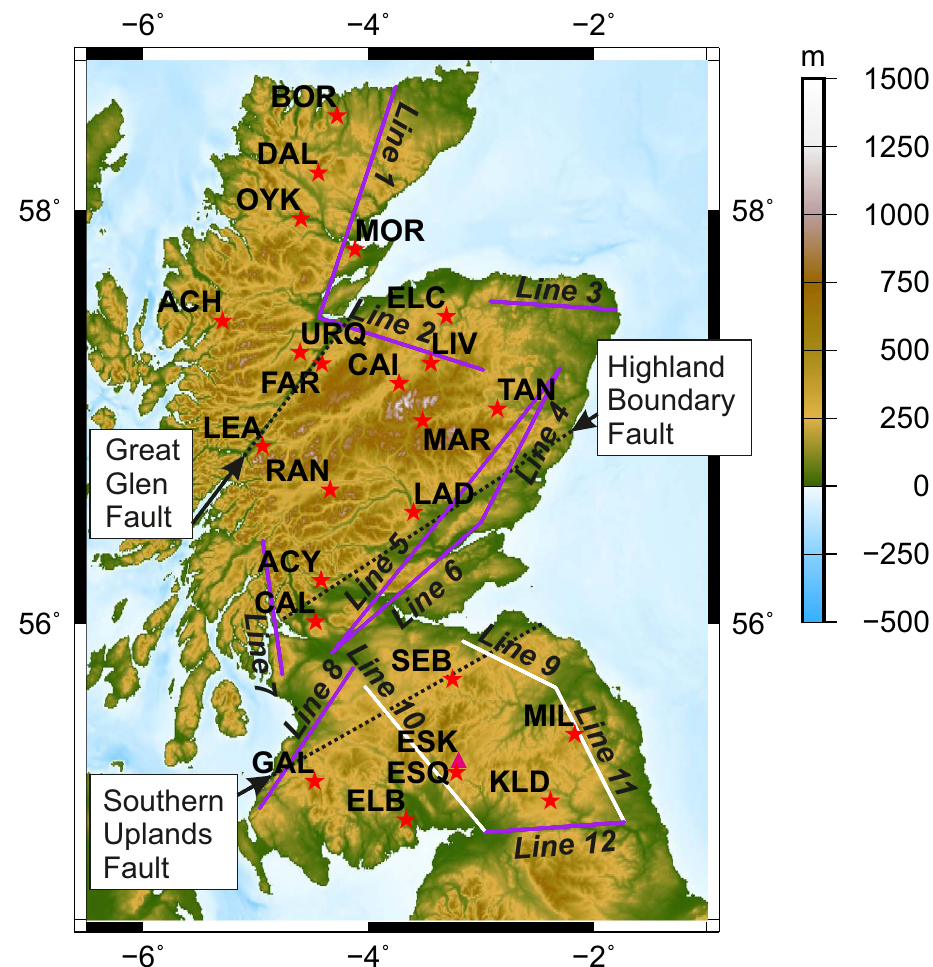
Fig. 1. Locations (red stars) and names of 23 MT sites installed in Scotland and northern England during 2017 and 2018. Pink triangle marks the position of ESK geomagnetic observatory. Purple and white lines are the longest (>50 km) 12 high-voltage – 275 kV and 400 kV, respectively – transmission lines in the region (Viljanen et al., 2013; Kelly et al., 2017). Dashed lines delineate the Great Glen Fault (Kennedy, 1946), Highland Boundary Fault (Tanner, 2008) and Southern Uplands Fault (Oliver et al., 2002). The highest topography is located between sites CAI and MAR. This region is referred to as the